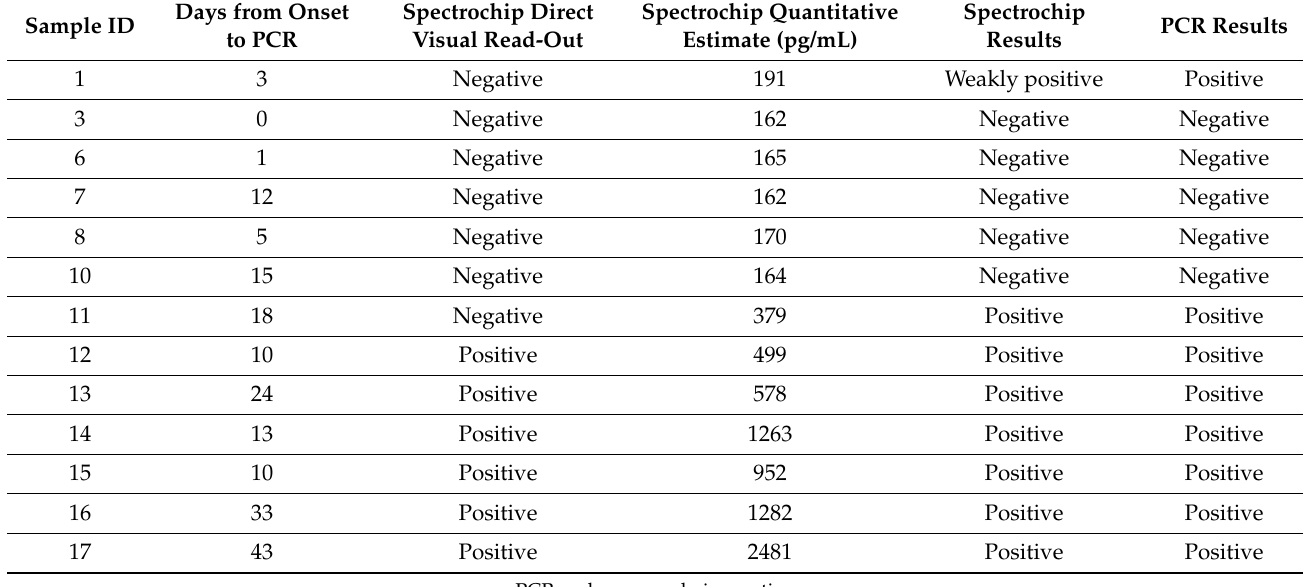
Table 1. Summary of results of a spectrochip and PCR test of enrolled patients.